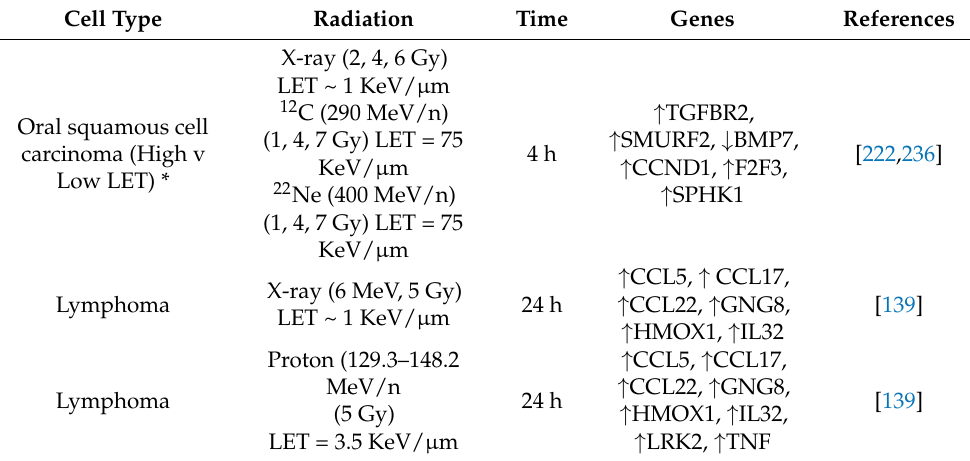
Table 5. Comparison of gene expression in cancer cells after low- or high-LET